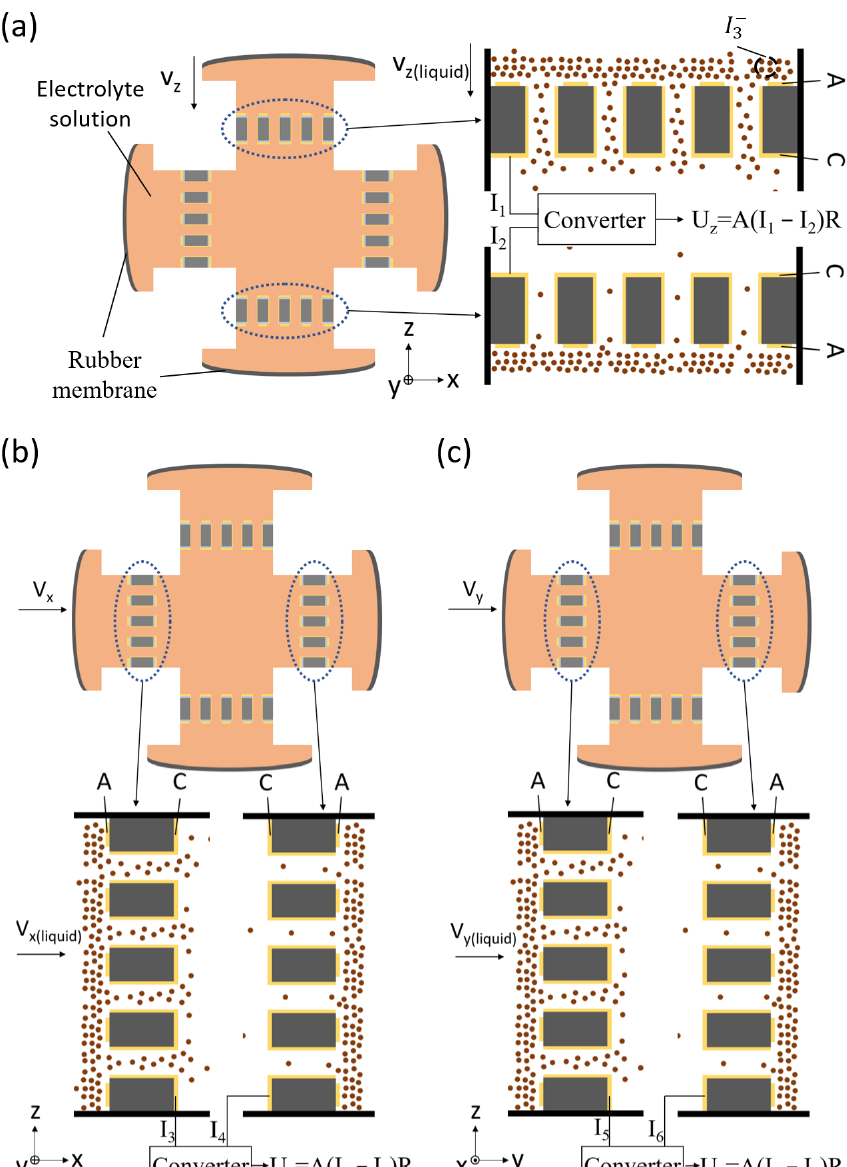
Figure 2. Working principle of the MEMS based integrated triaxial electrochemical seismometer, including ( a ) the working principle of the z-axis, ( b ) the working principle of the x-axis and ( c ) the working principle of the y-axis. In response to a vibration with an arbitraty direction, it was decoupled into x, y, and z directions, accordingly. Then, corresponding vibrations along individual axis lead to movements of electrolyte solution and ion movements around sensitve electrodes, which were translated into current outputs.